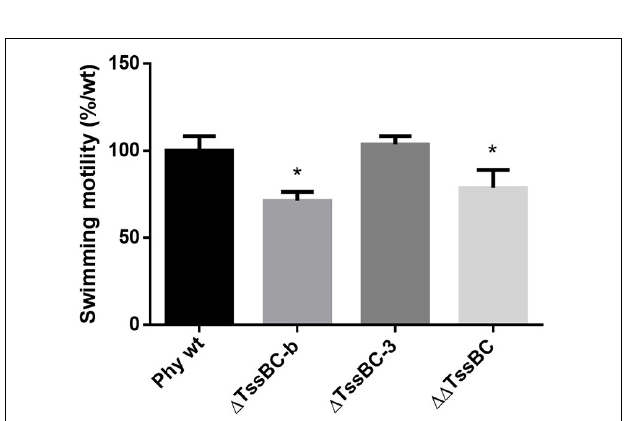
FIGURE 6 | Swimming motility of P phymatum wild-type, and the three deletions strains (cid:49) T6SS-b, (cid:49) T6SS-3, and (cid:49)(cid:49) T6SS was tested on LB media without salt. The diameter of the halo was measured after 4 days incubation at 28 ◦ C. Three biological replicates were analyzed using a one-way ANOVA (* p -value ≤ 0.05), respectively, and bars represent the standard